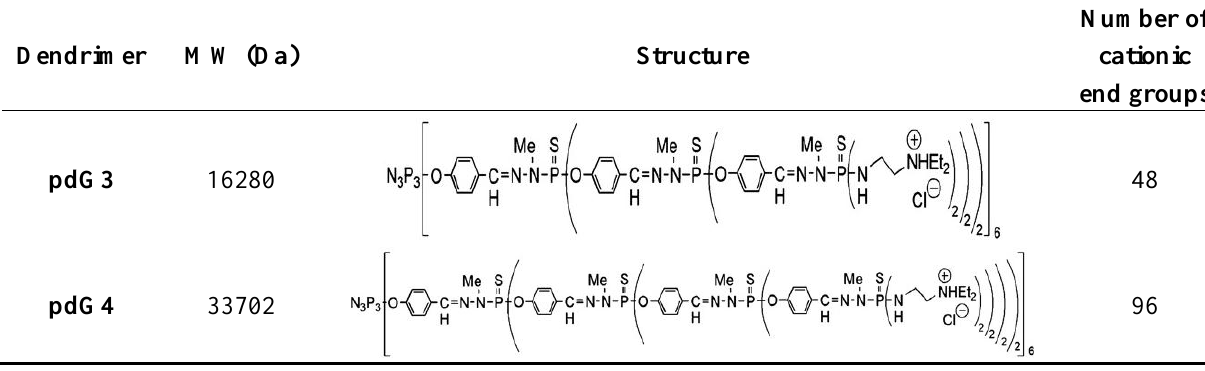
Table 2. Characterisation of phosphorus dendrimers of generation 3 and 4.